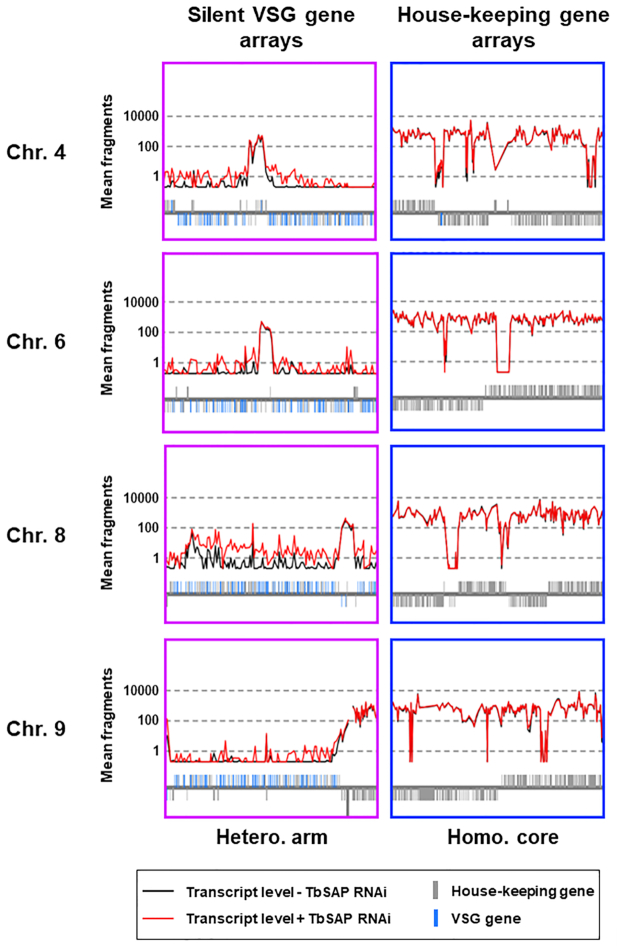
Increased transcription of silent VSGs present within the silent VSG sub-telomeric arrays after the induction of TbSAP RNAi for 72 h in MES-eGFP TbSAP RNAi cells. Transcript levels (mean fragment count over three replicates) in the presence (+) of TbSAP RNAi (red line) or absence (−) of TbSAP RNAi (black line) were mapped over the T. brucei megabase chromosomes. Below the traces gene architecture is shown, with housekeeping genes indicated with grey bars, and silent VSGs with blue bars. Magnified detail is presented from regions within chromosomes (Chr.) 4, 6, 8 and 9. These include regions within the silent VSG arrays present at the heterozygous transcriptionally silent aneuploid chromosomal arms (Hetero. arm). Alternatively, these regions are within the homologous transcriptionally active diploid chromosomal cores (Homo.core). In order to display on the log scale, counts of 0 have been set to 0.2).